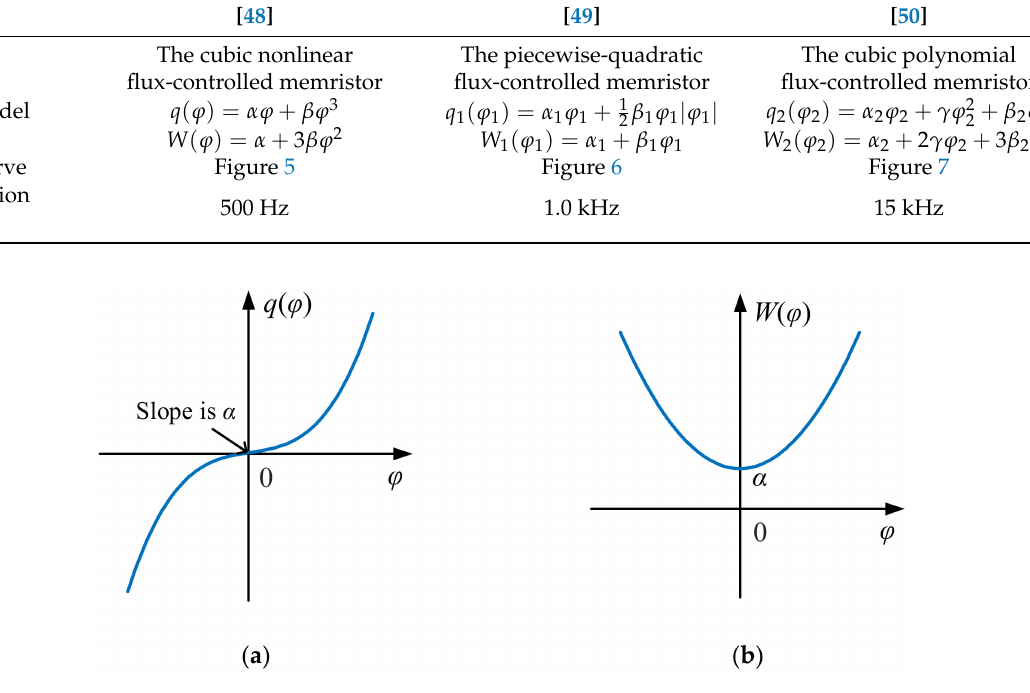
Figure 5. Characteristic curves of the cubic nonlinear flux-controlled memristor. ( a ) ϕ - q ( ϕ ); ( b ) ϕ - W ( ϕ